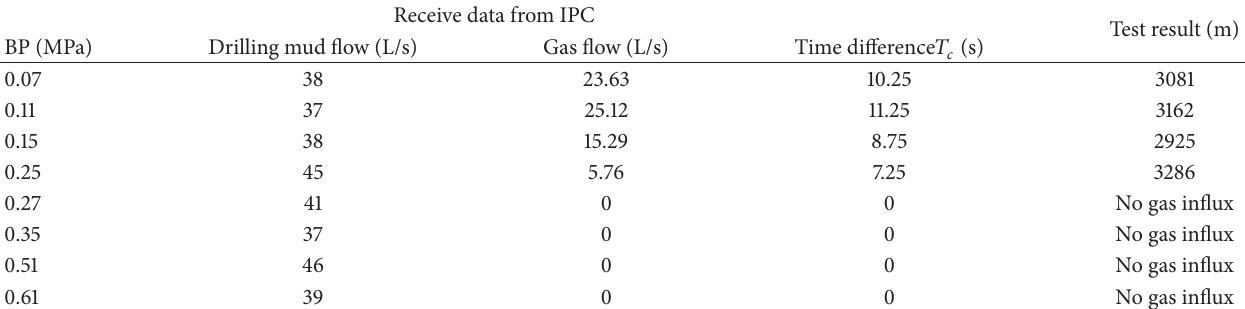
Table 2: Predicted position of gas influx during MPD operations.